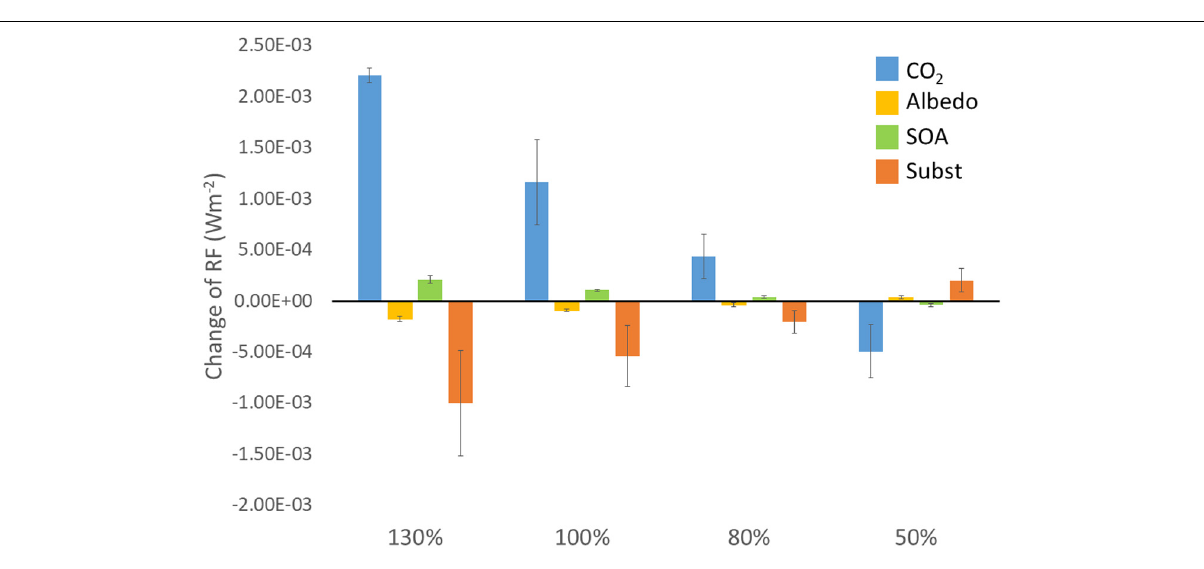
FIGURE 5 | Contribution of different factors to the average change of global radiative forcing (RF) in 50 years due to changes in Finnish forests in different harvest scenarios, expressed as difference from the baseline (65% CAI). The analysis was done at current climate. CO 2 includes carbon sequestered in trees, soil and wood products, ‘Albedo’ refers to the change in surface albedo, ‘SOA’ equals both direct and indirect effects of secondary organic aerosols, ‘Subst’ equals avoided emissions due to substitution of product materials and energy. Positive values indicate warming, and negative values cooling effect. The error bars indicate the estimated min-max